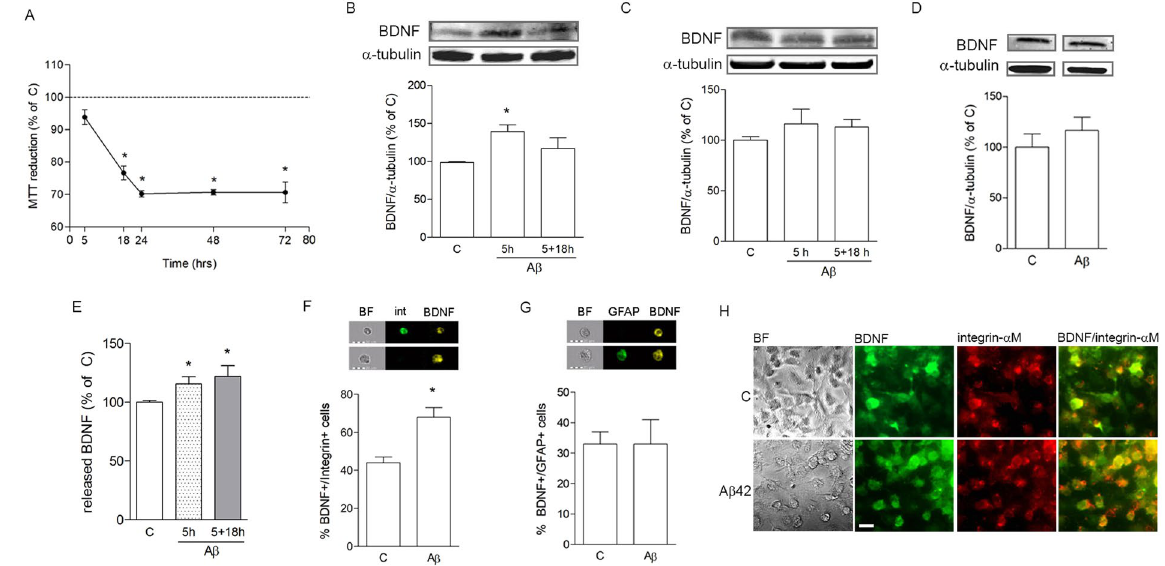
Figure 2. A β 42 selectively induces microglial mature BDNF expression and release. MTT analysis of A β 42 (0.5 μ M) toxicity on differentiated SH-SY5Y cells treated for different time points, as indicated ( A ). Western blot analysis of BDNF expression in pMG ( B ) or pAS ( C ) treated with A β 42 (0.5 μ M) for 5 h or pulsed for 5 h followed by medium change and further incubation without A β for 18 h (labeled as 5 + 18 h). Western blot analysis of BDNF expression in SH-SY5Y cells exposed to A β 42 (0.5 μ M) for 5 h ( D ). ELISA determination of released BDNF in medium collected from pMG treated for 5 h or 5 + 18 h ( E ). Image cytofluorometric analysis of co-localization of BDNF with integrin α -M (int; F ) or GFAP ( G ) in mxG cells. BF = brightfield. Double immunostaining of BDNF (green) and integrin α -M (red) in control vs A β 42-treated (0.5 μ M for 5 h) pMG ( H ). Scale bar is 20 μ m. Blots were cropped to display specific bands. Original blots are reported in Supplementary Fig. 1. Values are mean ± SEM with n = 3-5. * p < 0.05 vs. untreated control by one-way ANOVA followed by Newman-Keuls test for significance or Student’s t-test, as